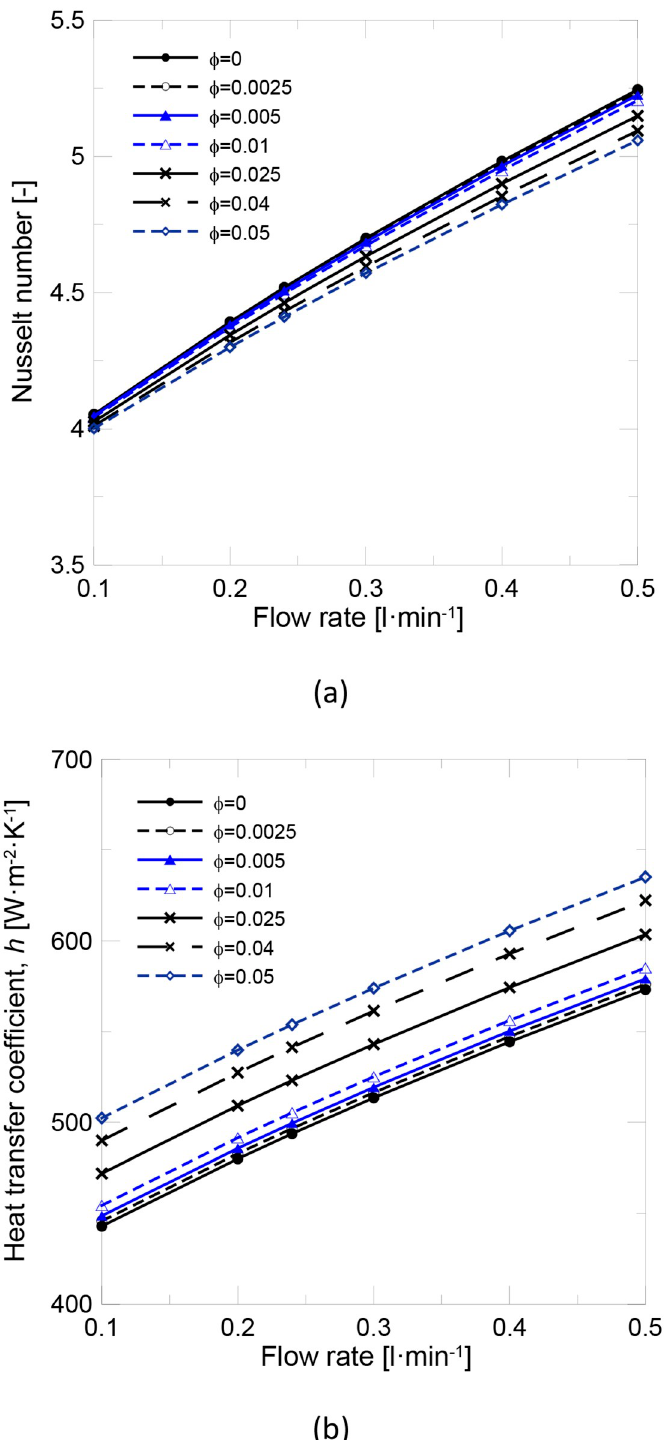
Fig 5. Evolution of (a) the Nusselt number and (b) the heat transfer coefficient with flow rate and volume fraction.